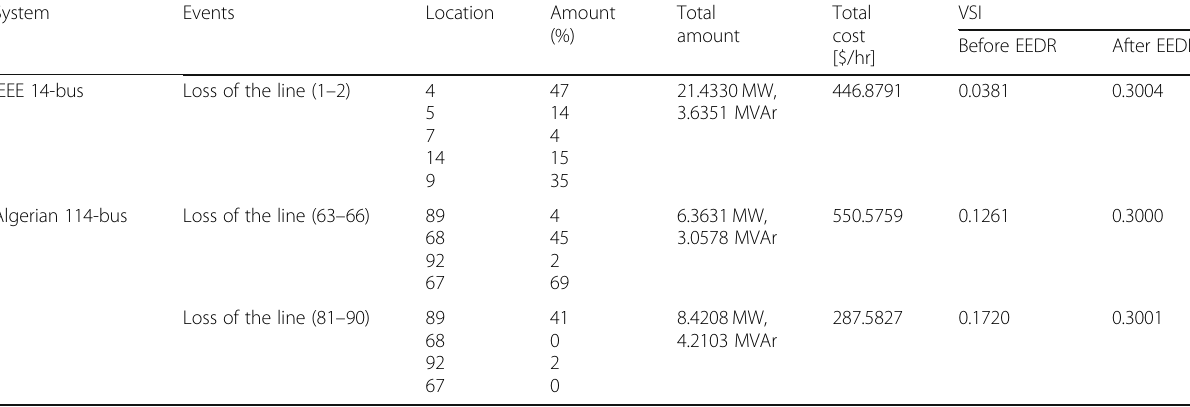
Table 3 EEDR results in IEEE 14-bus and Algerian 114-bus systems in the case of line tripping System Events